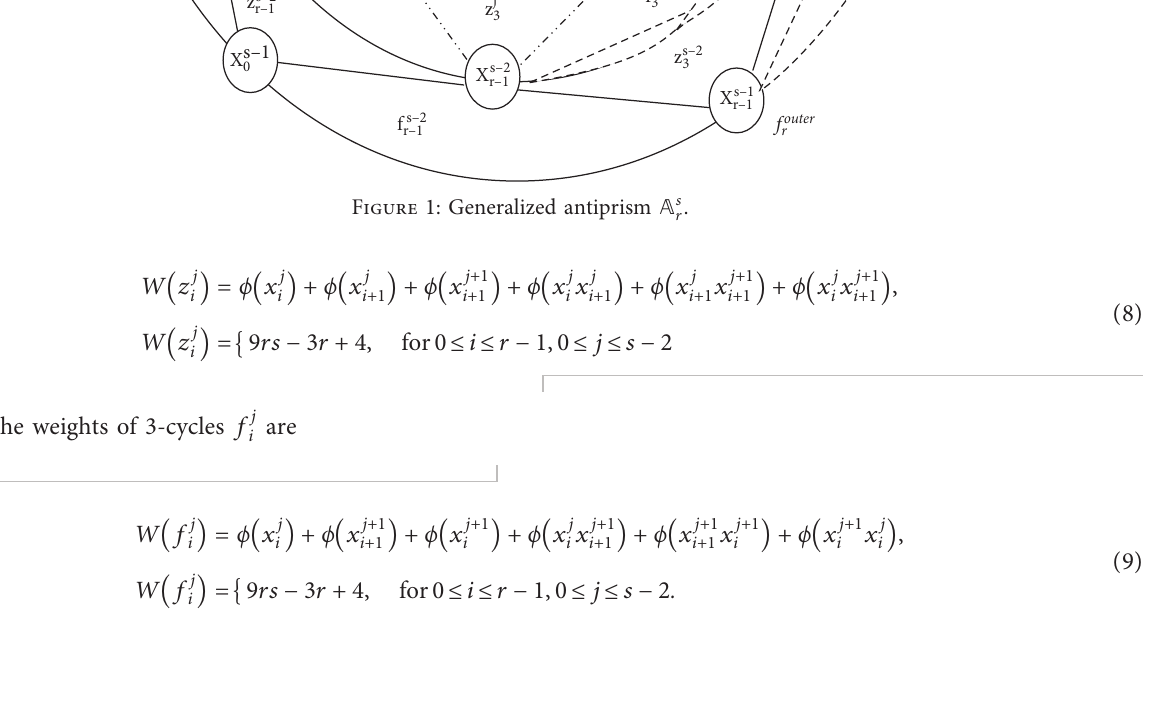
Figure 1: Generalized antiprism A s